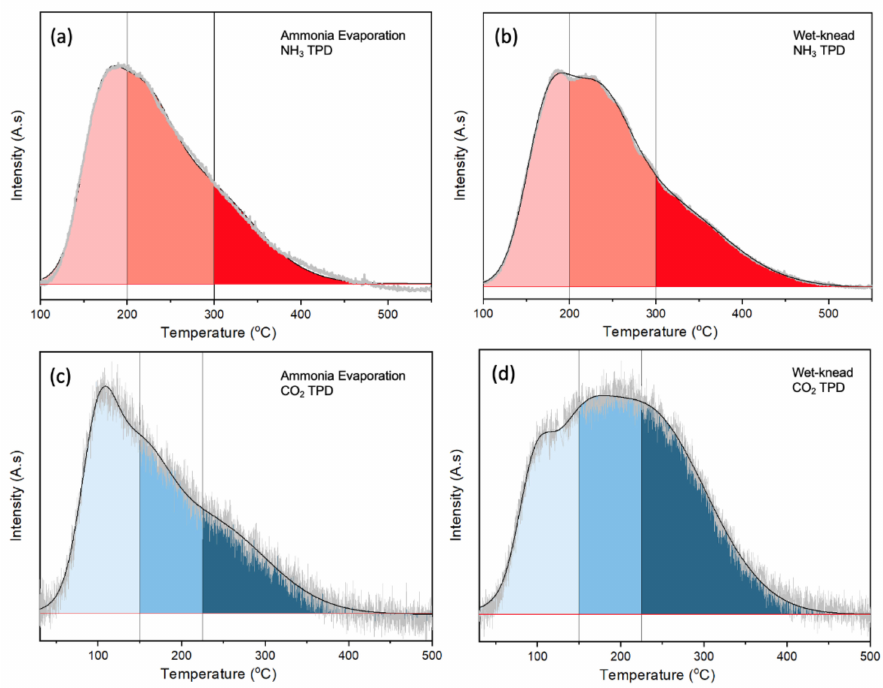
Figure 4. TPD of ( a , b ) NH 3 and ( c , d ) CO 2 over MgO-SiO 2 -4 catalysts prepared by ammonia evapora- tion and